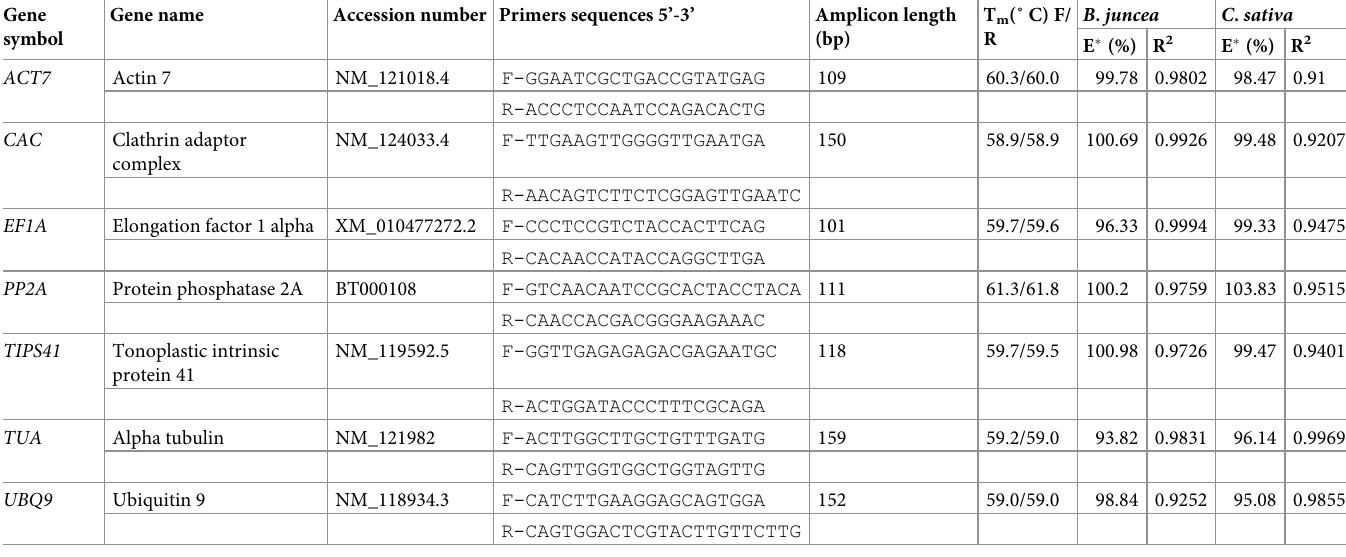
Table 1. Description of the seven candidate reference genes adopted in the